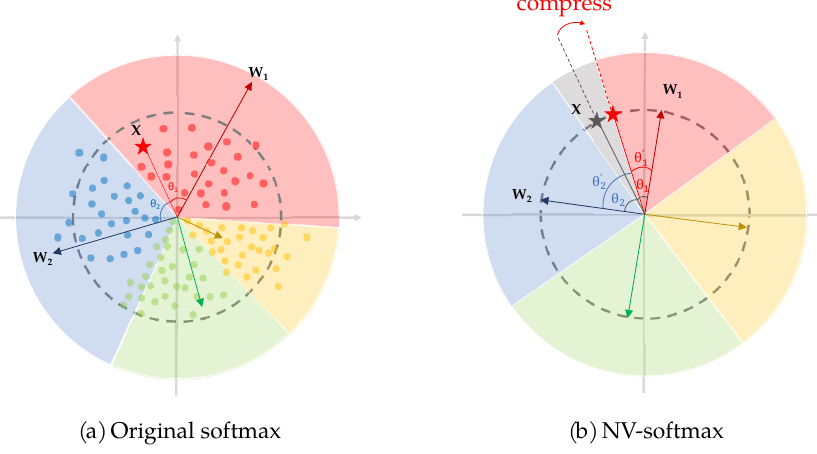
Figure 9. The feature space of original softmax and normalized virtual softmax. The loss back propagates (Equation (7)) to modify the parameters of the network to make the samples away from the boundaries and move closer to the anchor of the class they belonging to. The farther the samples are from the boundaries, the less likely the network is to misclassify. So, it is easy to come up with an idea to create some “no-man’s land” between two adjacent space to promote this process, which is the original purpose of the virtual